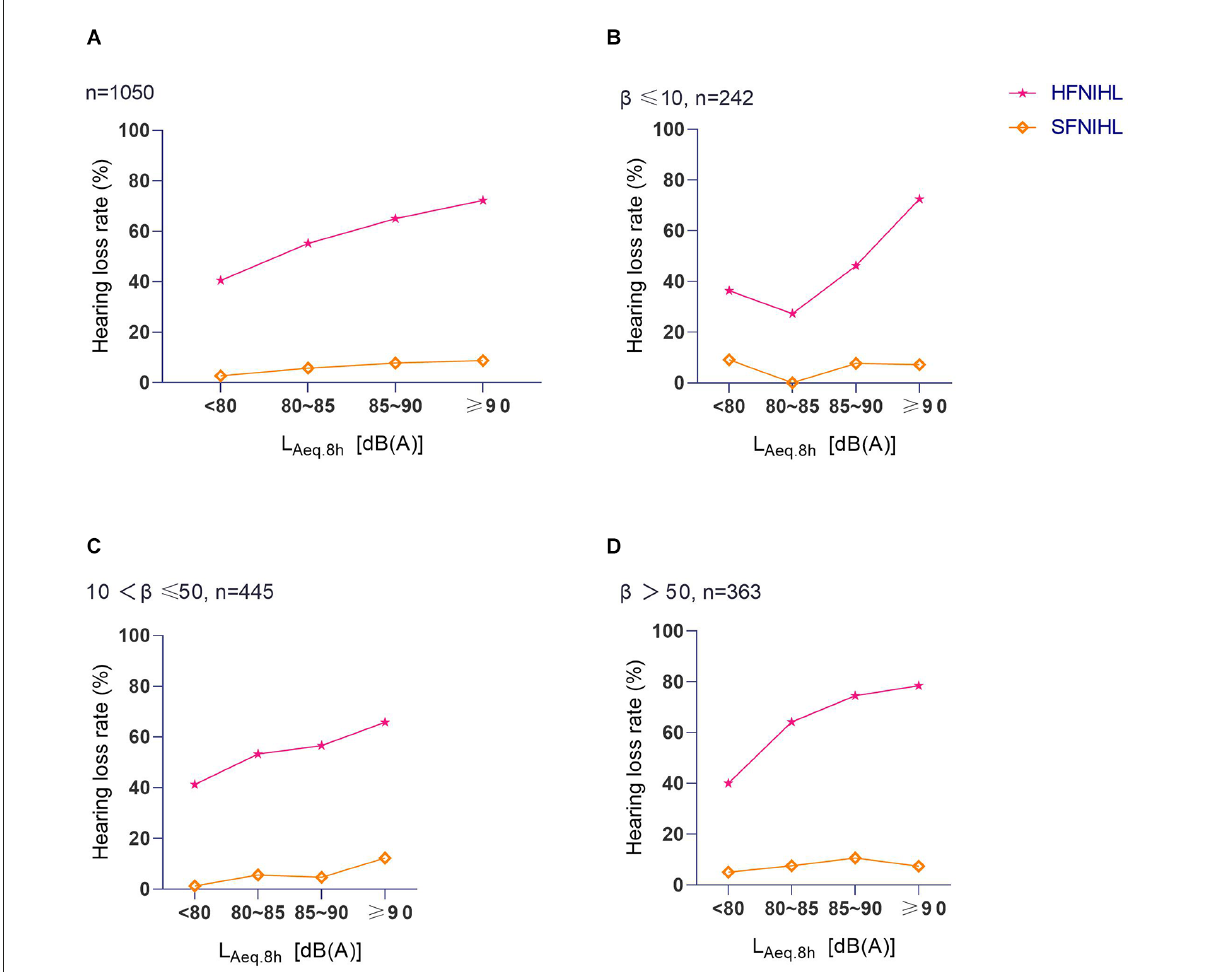
FIGURE2 The relationship between L Aeq.8h and hearing loss at different kurtosis levels. (A) The HFNIHL% and SFNIHL% of different L Aeq.8h groups. (B) The HFNIHL% and SFNIHL% of different L Aeq.8h groups when β ≤ 10. (C) The HFNIHL% and SFNIHL% of different L Aeq.8h groups when β was between 10 and 50. (D) The HFNIHL% and SFNIHL% of different L Aeq.8h groups when β >